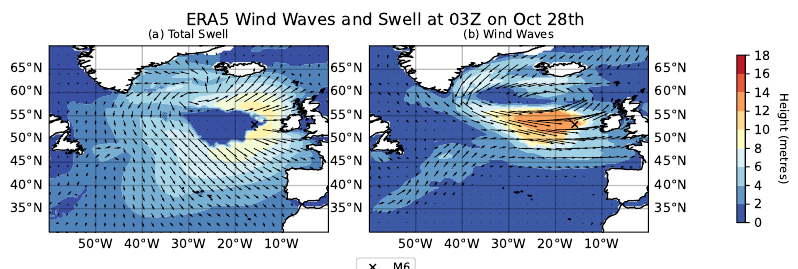
Figure 9. ERA5 breakdown of swell and wind waves at 03Z 28 October, the nearest ERA5 timestep to the rogue wave measurement at M6 buoy. The location of maximum wave heights is indicated, along with the M6